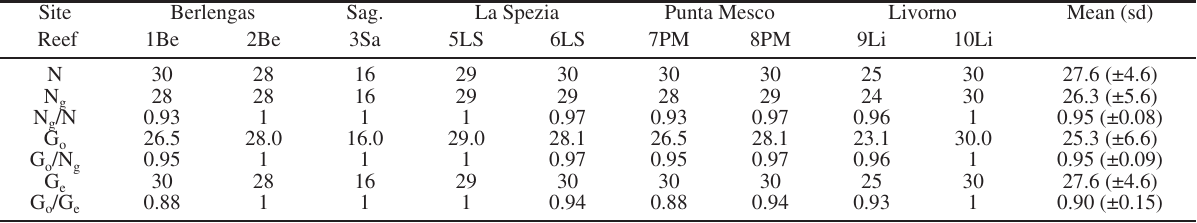
/N, genotypic richness; G , observed genotypic g o